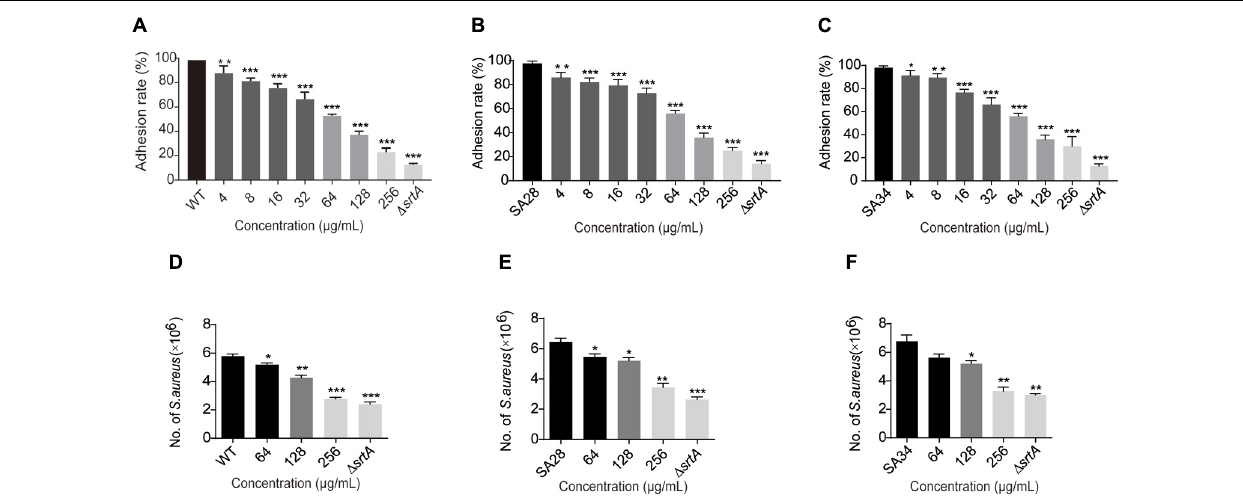
FIGURE 2 | Eriodictyol inhibition on the adherence and invasion of S. aureus USA 300 and clinical isolates. (A–C) The effect of eriodictyol on the adhesion of S. aureus USA 300 and clinical isolates SA28 and SA34 to fibrinogen. (D–F) Eriodictyol suppressed the internalization of S. aureus USA 300 and clinical isolates SA28 and SA34 into A549 cells. A549 cells were infected with S. aureus pretreated with various concentrations of eriodictyol and lysed 2 h after the infection; the number of viable S. aureus in the cells was quantified by serial dilution on LB agar plates. The data are shown as the mean ± SEM (error bars) of three replicates.